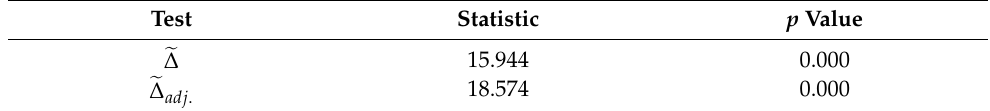
Table 3. Results of Homogeneity Tests.